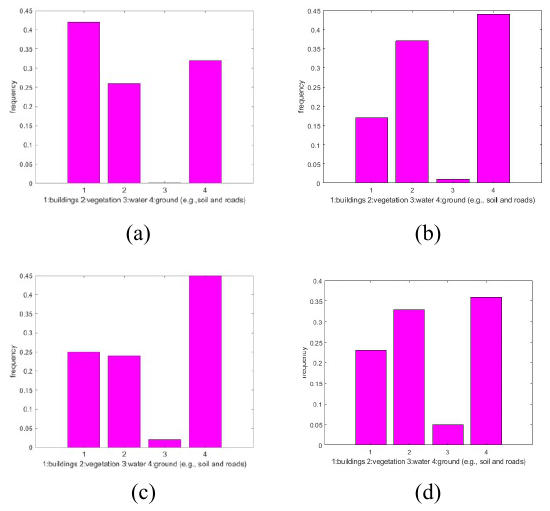
Figure 4. Image-based histograms as resulting from Figure 2: (a) QuickBird image of “Scene 1”. (b) WorldView image of “Scene 1”. (c) QuickBird image of “Scene 2”. (d) WorldView image of “Scene 2”.